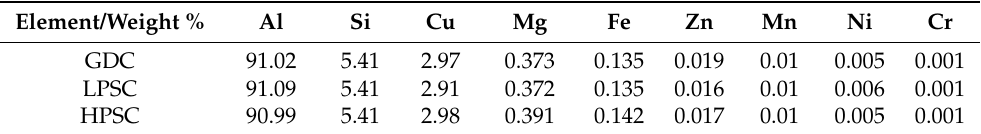
Table 1. Chemical composition of novel alloy designed. Element/Weight %